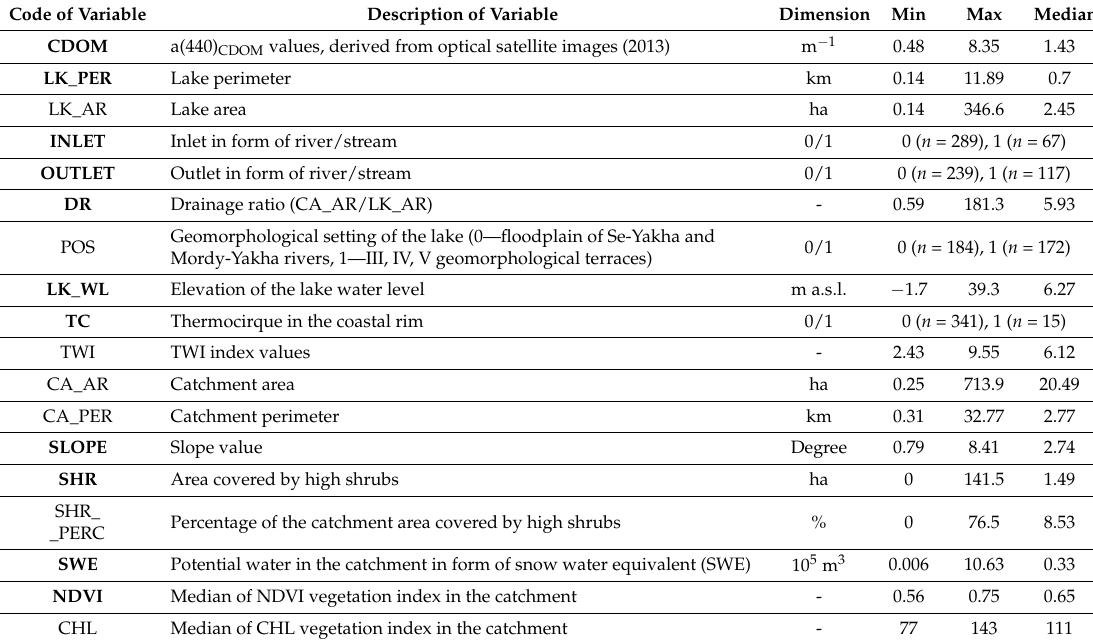
Table 3. List of lake and lake catchment characteristics used in CDOM statistical model. Variables in bold type were used in the final statistical